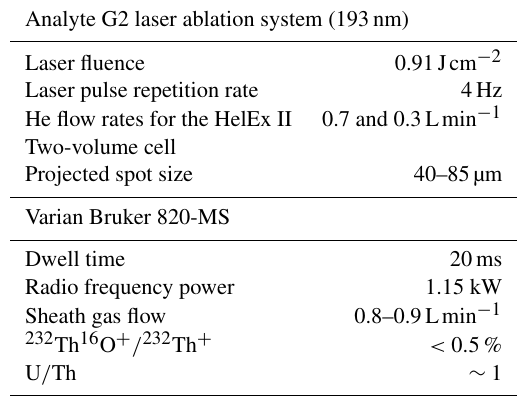
Table 1. Summary of LA-ICP-MS operating